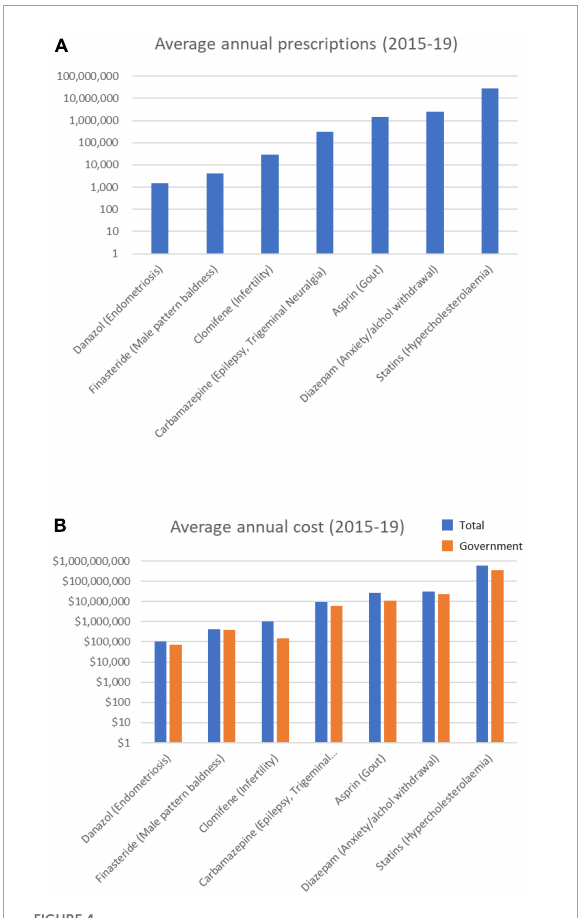
FIGURE4 Average annual prescription numbers (A) and costs (B) for members of the Uncertain category of drugs associated with cataract, together with typical conditions for which they are